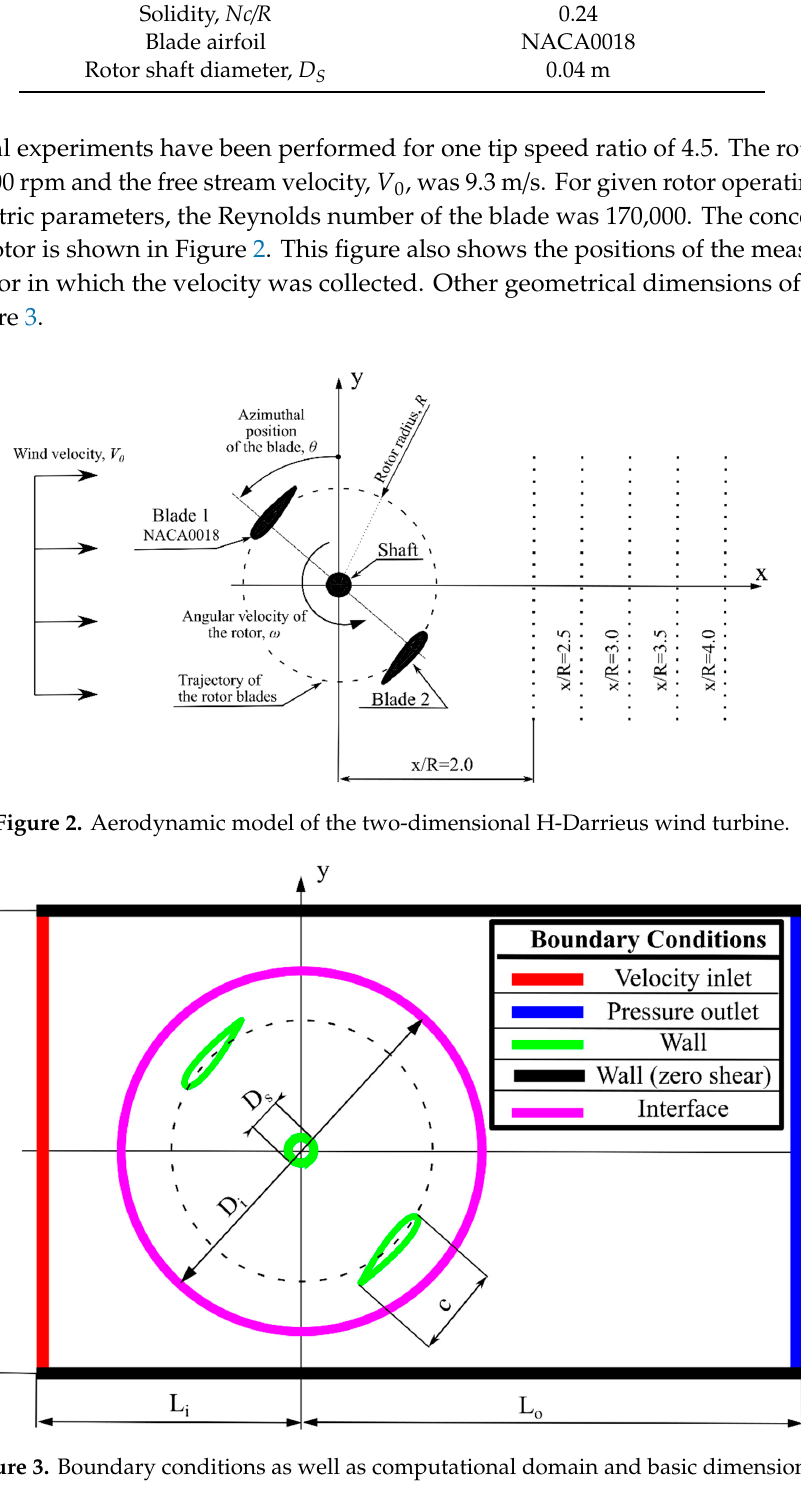
Figure 3. Boundary conditions as well as computational domain and basic